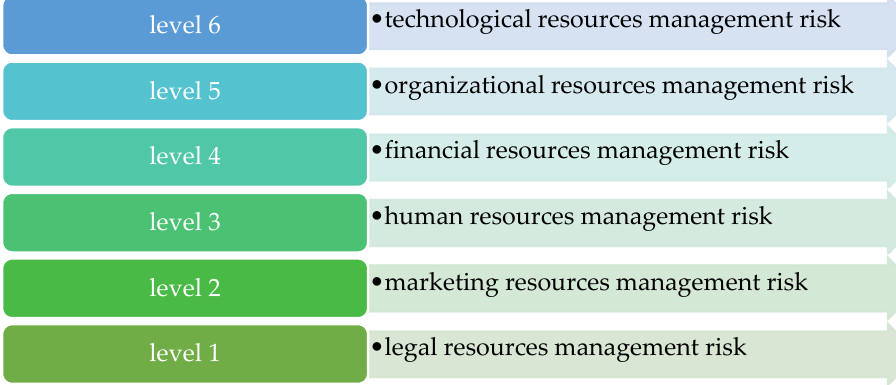
Figure 2. Risk levels of company resource management.